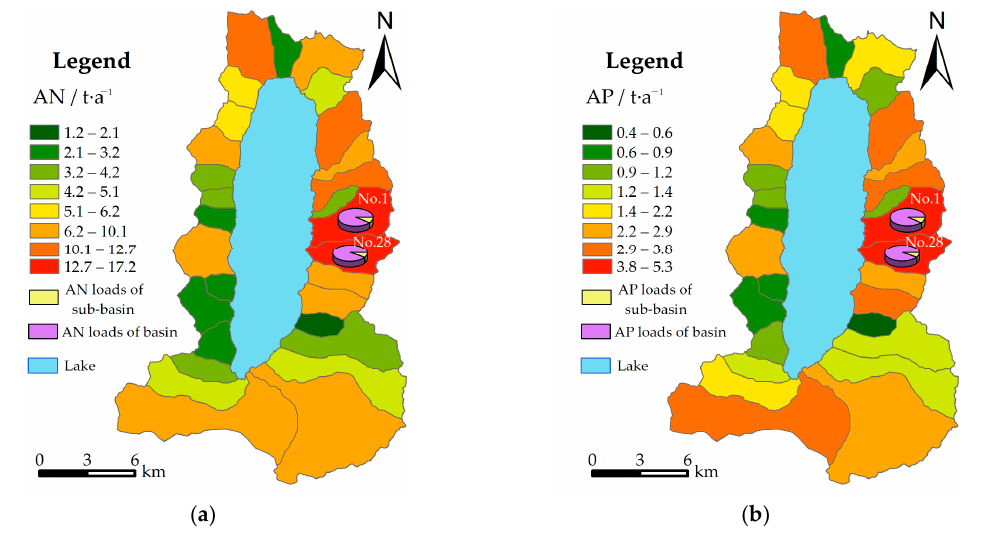
Figure 10. Spatial distributions of the ( a ) AN and ( b ) AP loads discharged into Lake Chenghai. Table 5. Loads and contribution ratios of AN and AP from different regions.